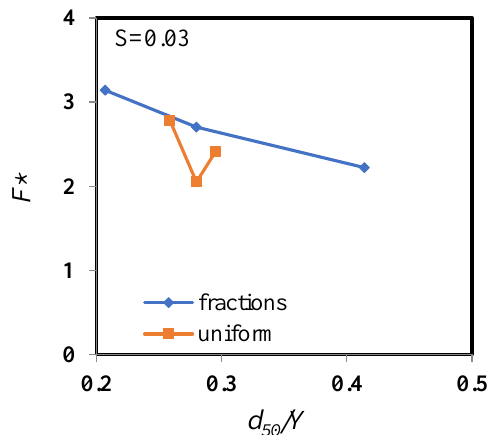
Figure 8. Comparison between particle Froude number for sediment sizes of 10.35, 14, and 20.7 mm in the fractions of the graded and uniform beds with a slope of 0.03.